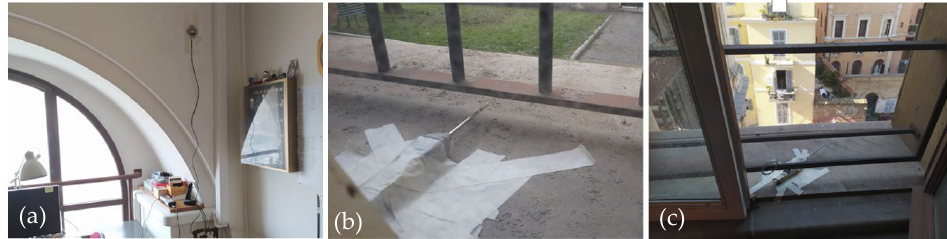
Figure 2. Indoor thermal conditions monitoring: M1 (a), M2 (b), M3 (c).